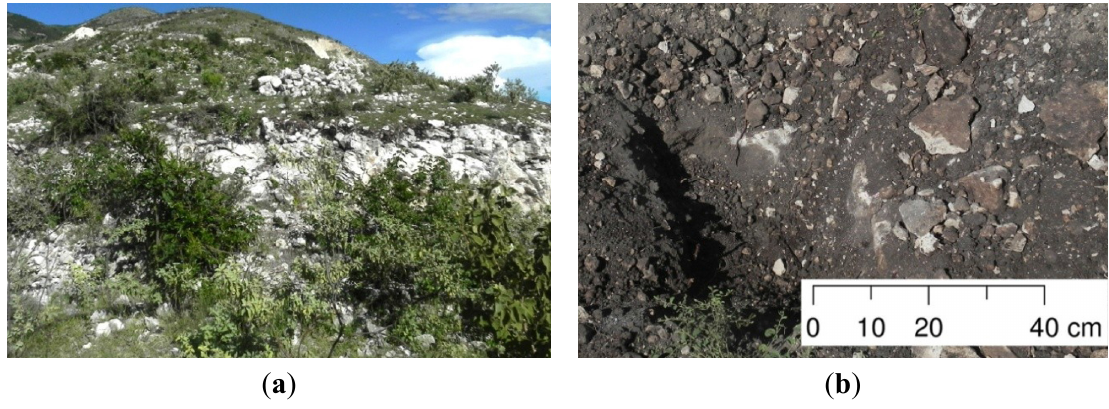
Figure 10. Vegetation cover ( a ) and soil texture ( b ) at one sample